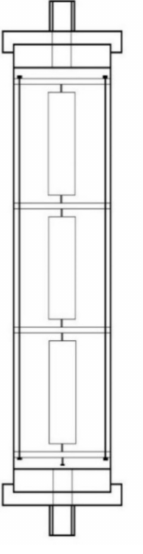
Figure 6. Scheme of cores in the